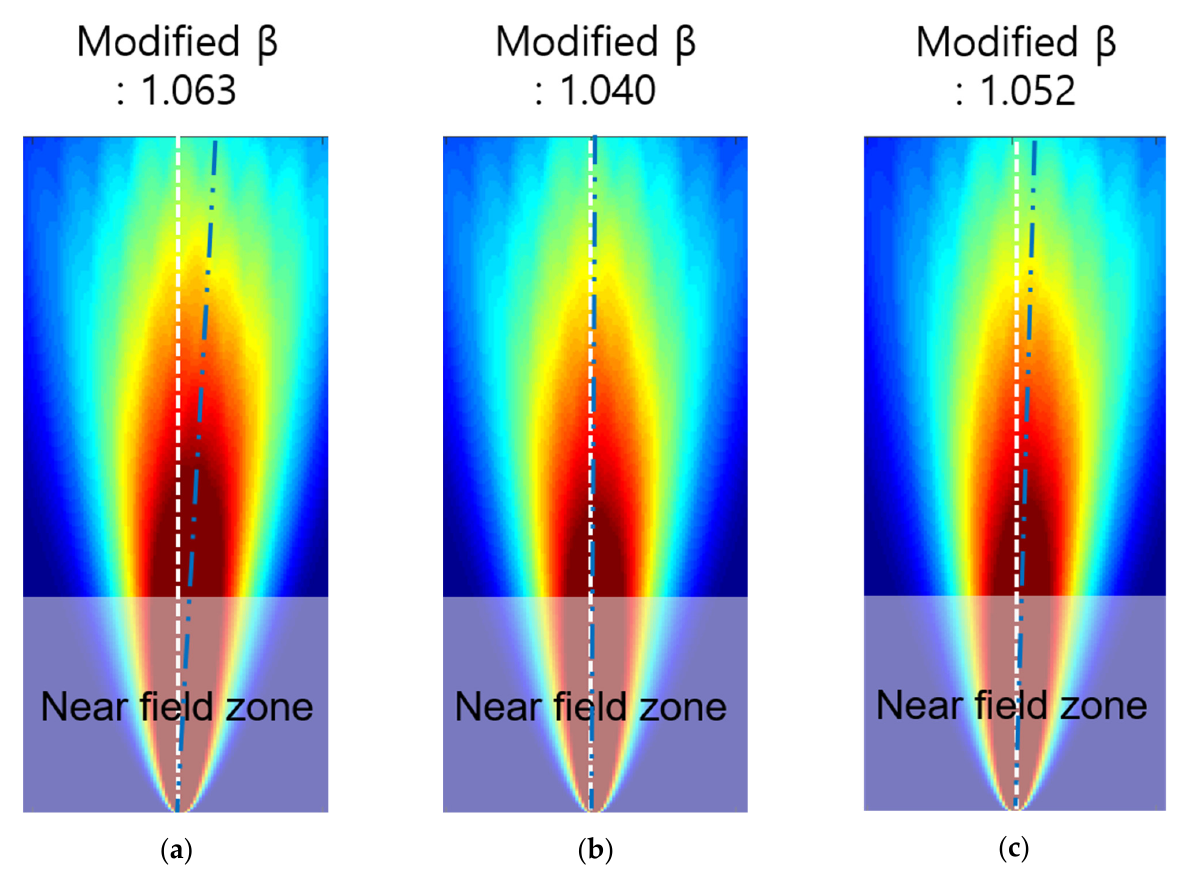
Figure 16. Revised shape function of variable β for RAPID tomography: ( a ) S0 2.64 MHz ‧ mm, ( b ) S0 2.70 MHz ‧ mm, and ( c ) S0 2.76 MHz ‧ mm.